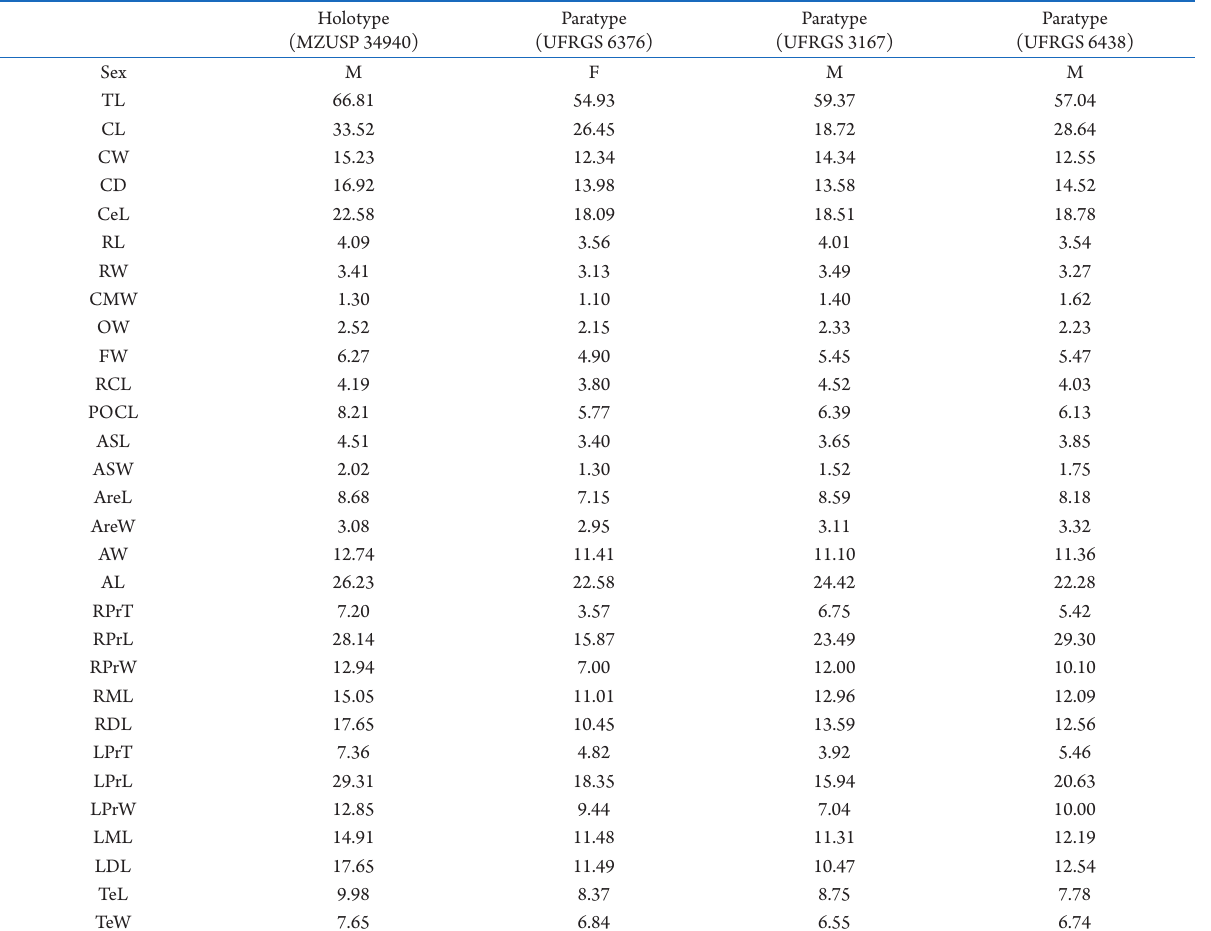
Table 1. Measurements (mm) of the type series of Parastacus tuerkayi sp. nov. For abbreviations, see Material and